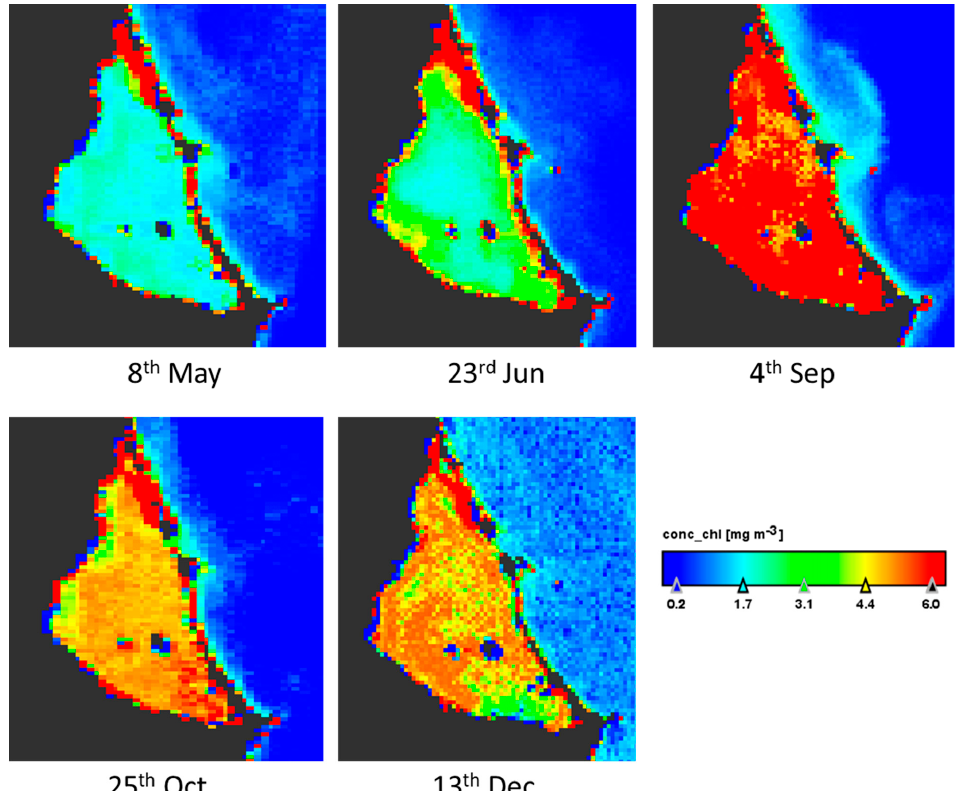
Figure 4. Thematic maps of Chlorophyll-a concentration (µg/L) in surface of Mar Menor lagoon in the dates of 2017 indicated below each image. Note that the red area in North corresponds to the salt evaporation ponds of San Pedro del Pinatar.